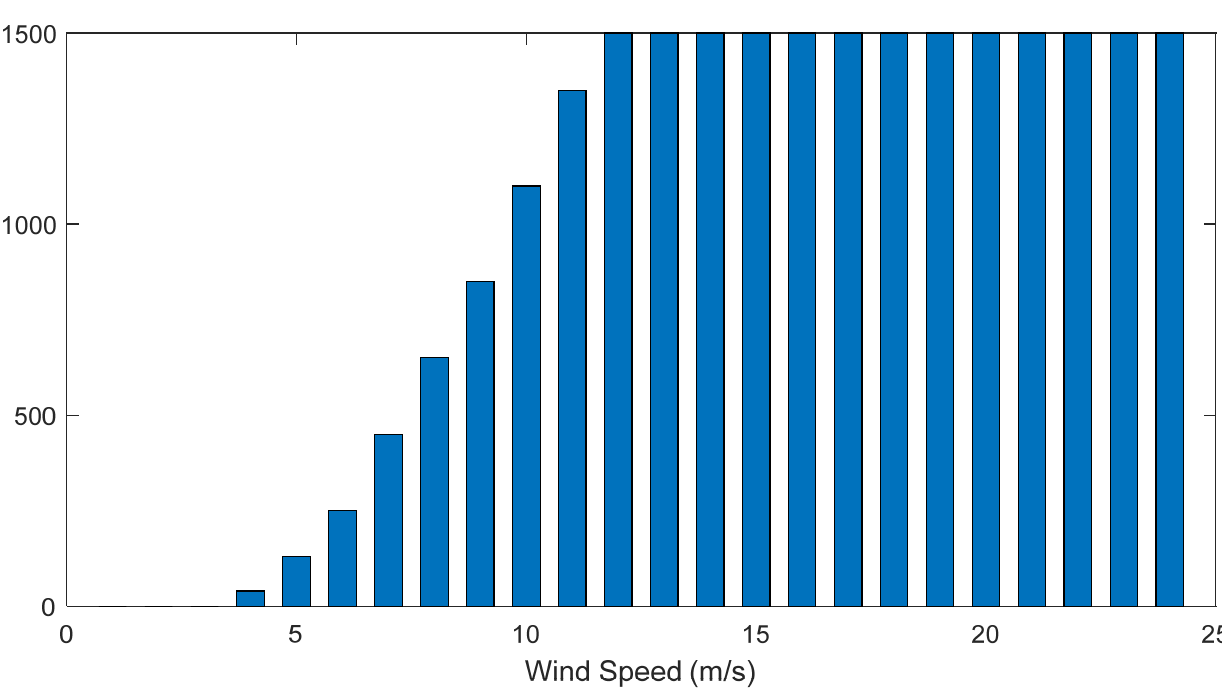
Figure 6. Wind turbine power in terms of wind speed.